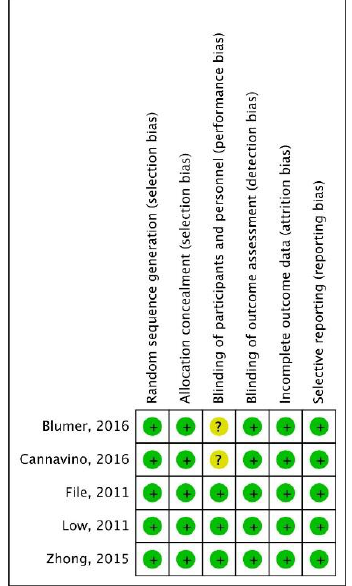
Figure 2. Risk of bias per study and domain.